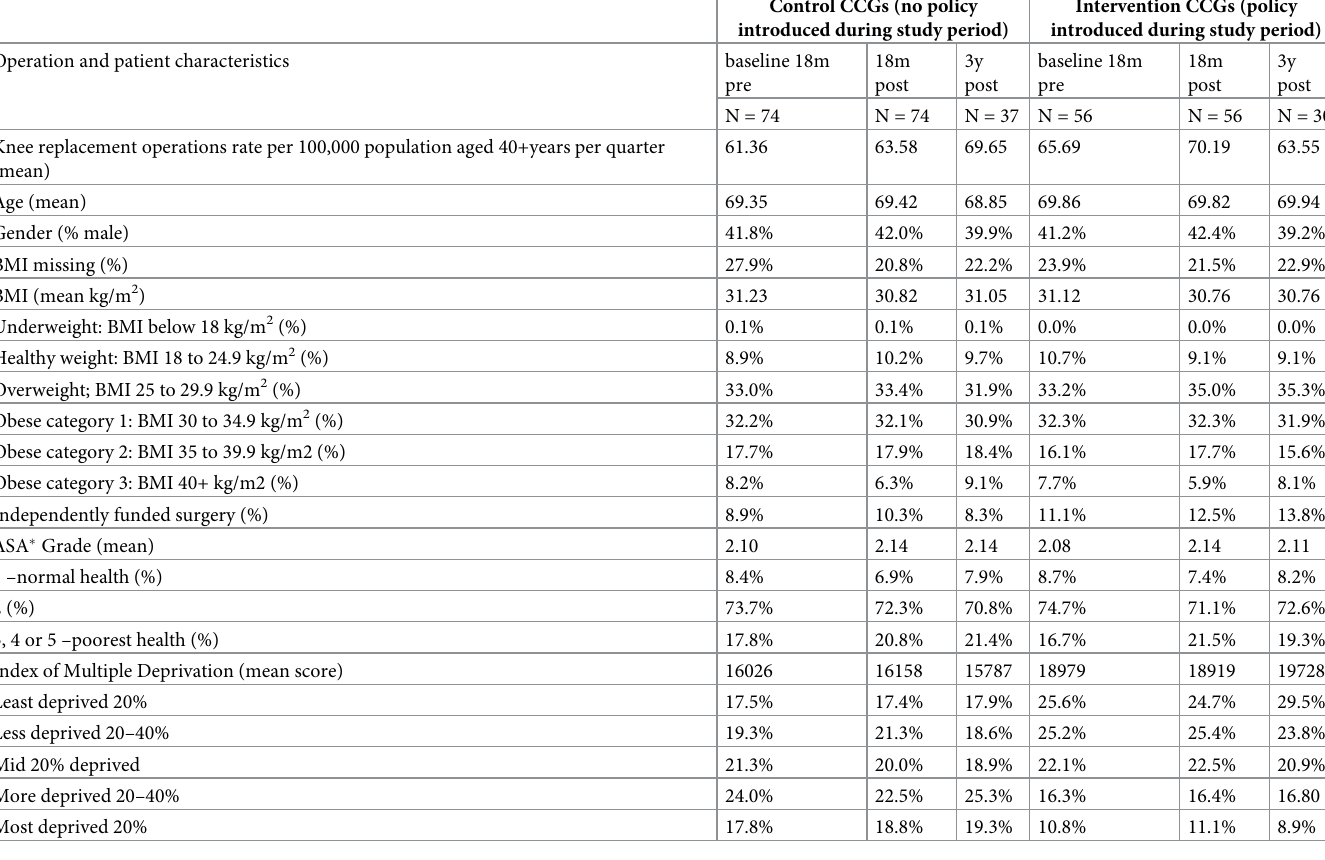
Control CCGs (no policy Intervention CCGs (policy introduced during study period) introduced during study